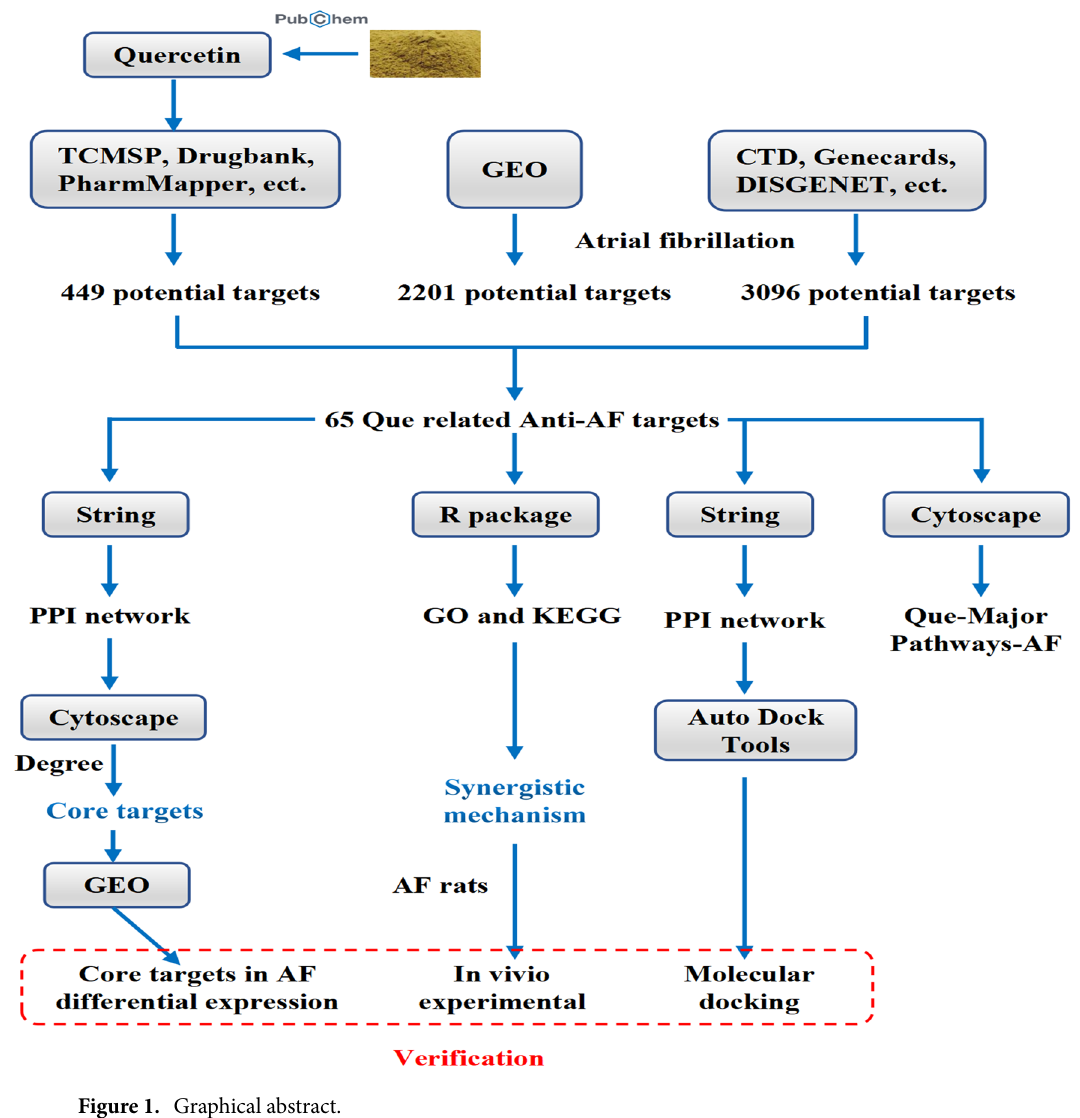
Figure 1. Graphical